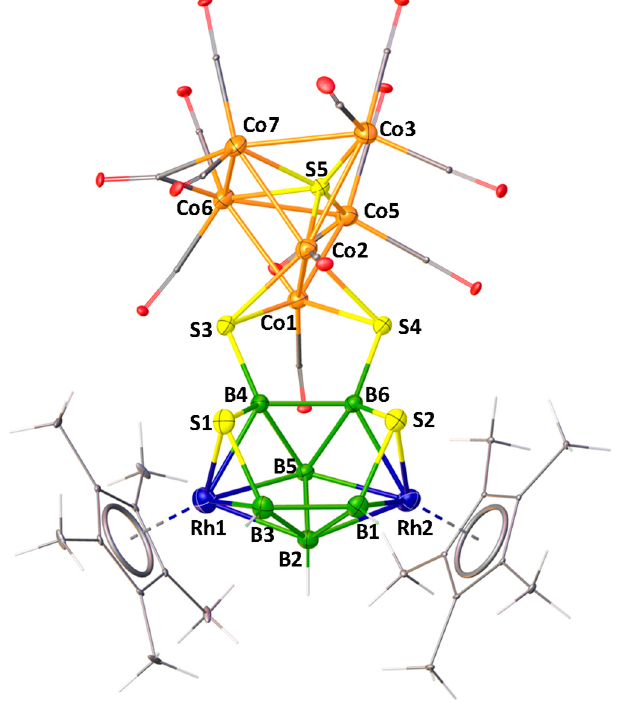
Figure 6. Molecular structure and labelling diagram of 8 . Selected bond lengths (Å) and angles (°). 8: Co1 − Co2 2.4288(6), Co1 − S5 2.2790(8), Co1 − Co6 2.5962(5), Co6 − Co7 2.6164(7), B4 − S3 1.868(3), Co1 − S3 2.2313(9); Co1 − S5-Co2 64.63(2), Co3 − S5-Co5 137.88(4).